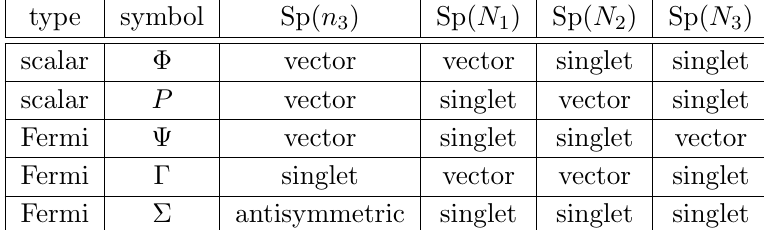
Table 3 . The matter content of the family of Sp( n 3 ) gauge